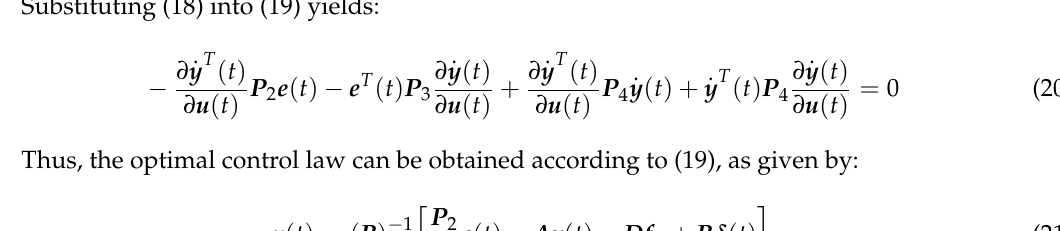
Figure 2. Logic diagram of a beat delay compensation using robust nonlinear predictive current control (RNPCC) method.